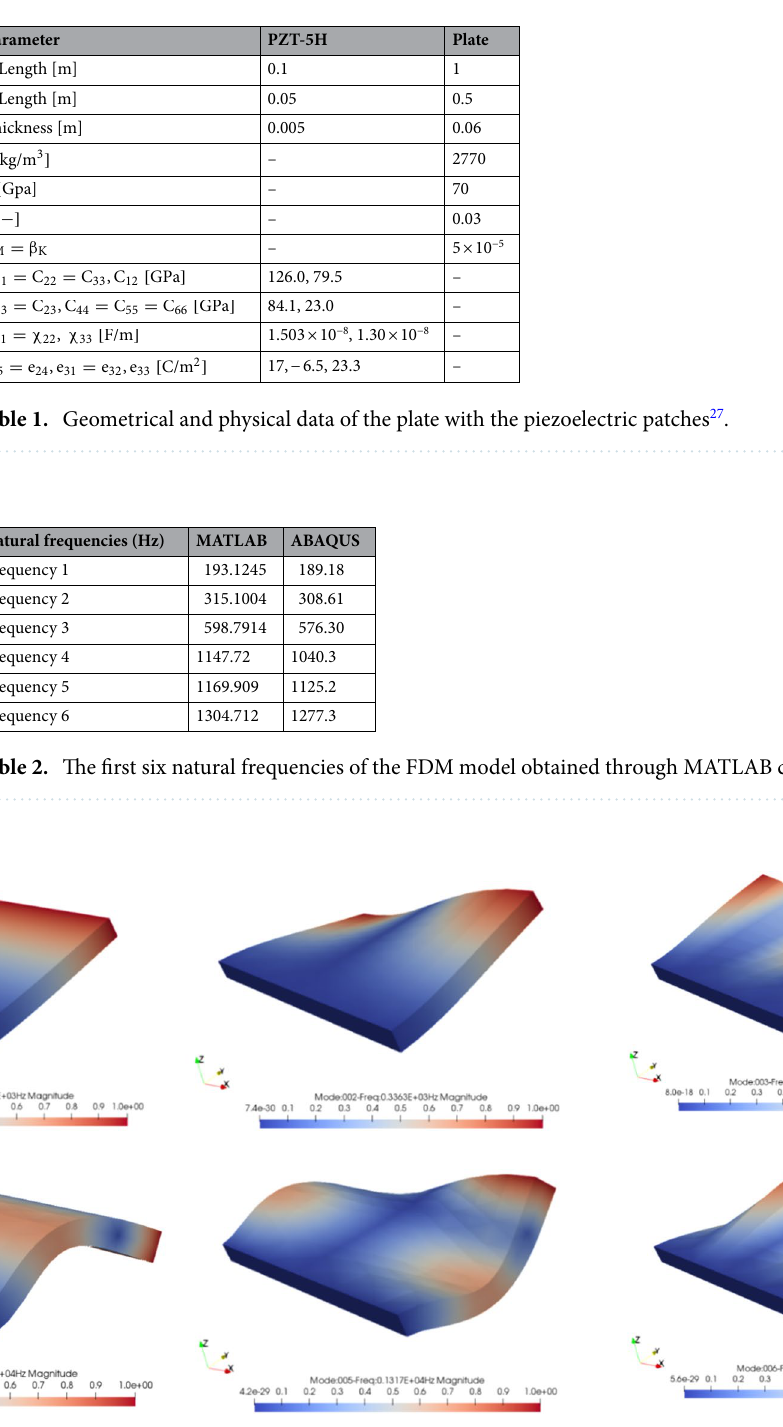
Figure 8. The first six modal shapes of a thick cantilever plate by